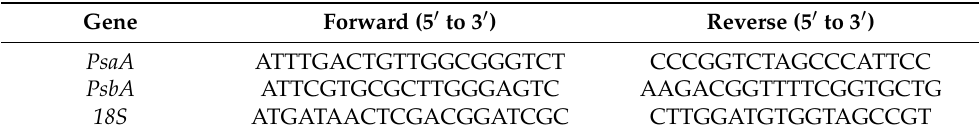
Table 2. The nucleotide sequences of primers used in the present